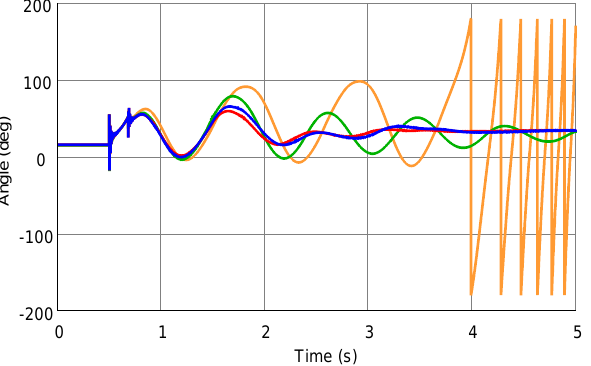
Figure 16. Machine A angle against 10.9-cycle fault: no SVC (yellow), SVC in local control mode (green), proposed RTDS-based WAC-SVC (red), and delay-compensated HIL-based WAC-SVC